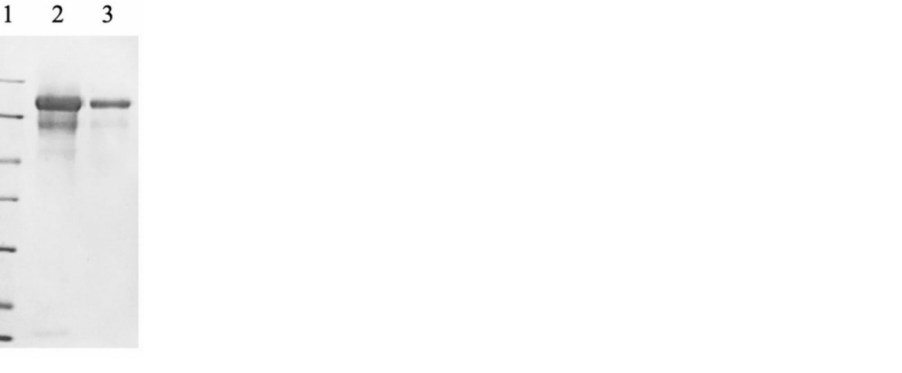
Figure 3. SDS-PAGE analysis of myr- ∆ 19 after purification: lane 1—molecular weight marker; lane 2—ion-exchange chromatography with DEAE-Sepharose, lane 3—subsequent desalting on a 30 kDa cut-off membrane.